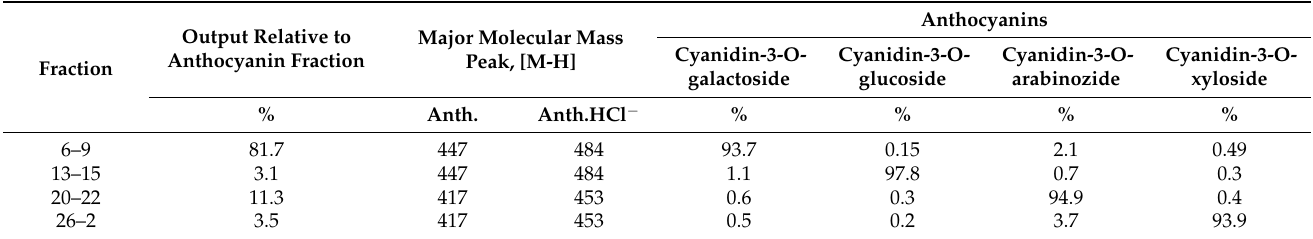
Table 3. Column chromatography output of individual anthocyanin fractions.